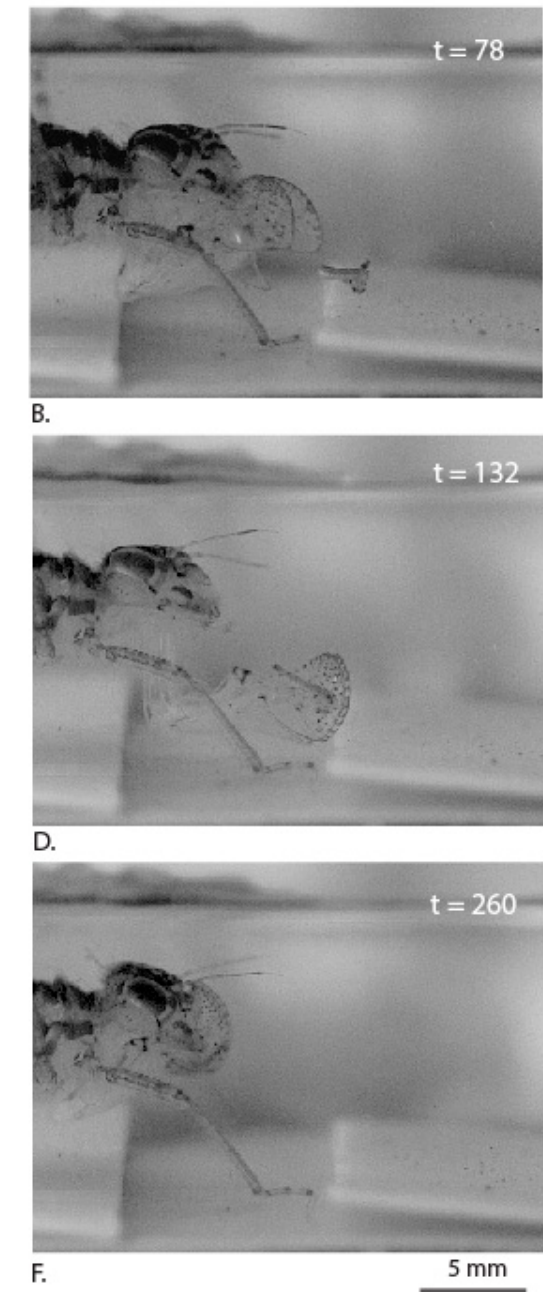
Figure 3. Sequence of movements (side view) used by the dragonfly nymph labium steps to capture mosquito larvae, at different time points ( A – F ).